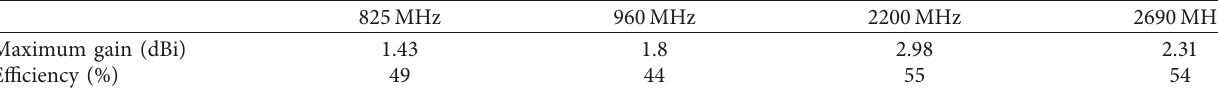
Table 2: Measured antenna gains and total efficiency of